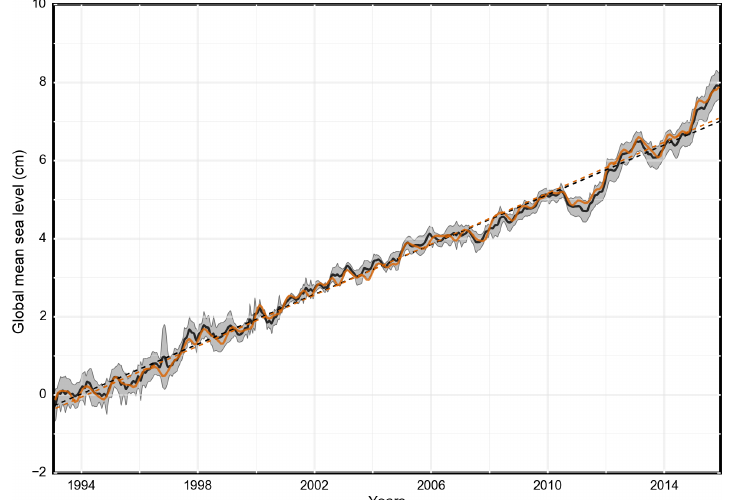
Figure 1. Comparison of the SL_cci v2.0 global MSL (solid orange line) with the associated linear trend (dashed orange line) and the ensemble mean (solid black line) of the global MSL derived from different groups (DUACS DT2014, CSIRO, Colorado University, GSFC and NOAA) with the associated linear trend (dashed black line) during the period 1993–2015. During this period, the trend of the SL_cci global MSL amounts to 3.3 ± 0.5mmyr − 1 with a 90% confidence interval. The grey envelope shows 1.65 SD of the ensemble mean (90% confidence interval). The seasonal variations have been removed and an offset has been introduced so that the mean of the 1993 data is set to